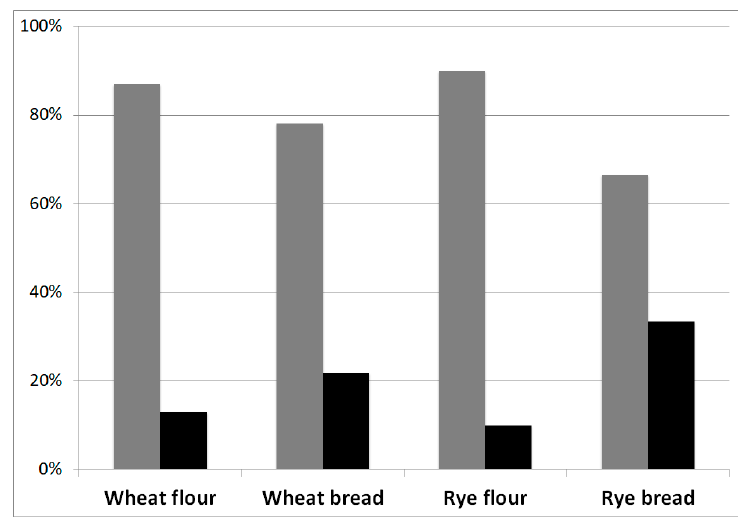
Figure 2. Histograms representing the percentage of -ine (grey histogram) and -inine (black histogram) content in each analysed food category.